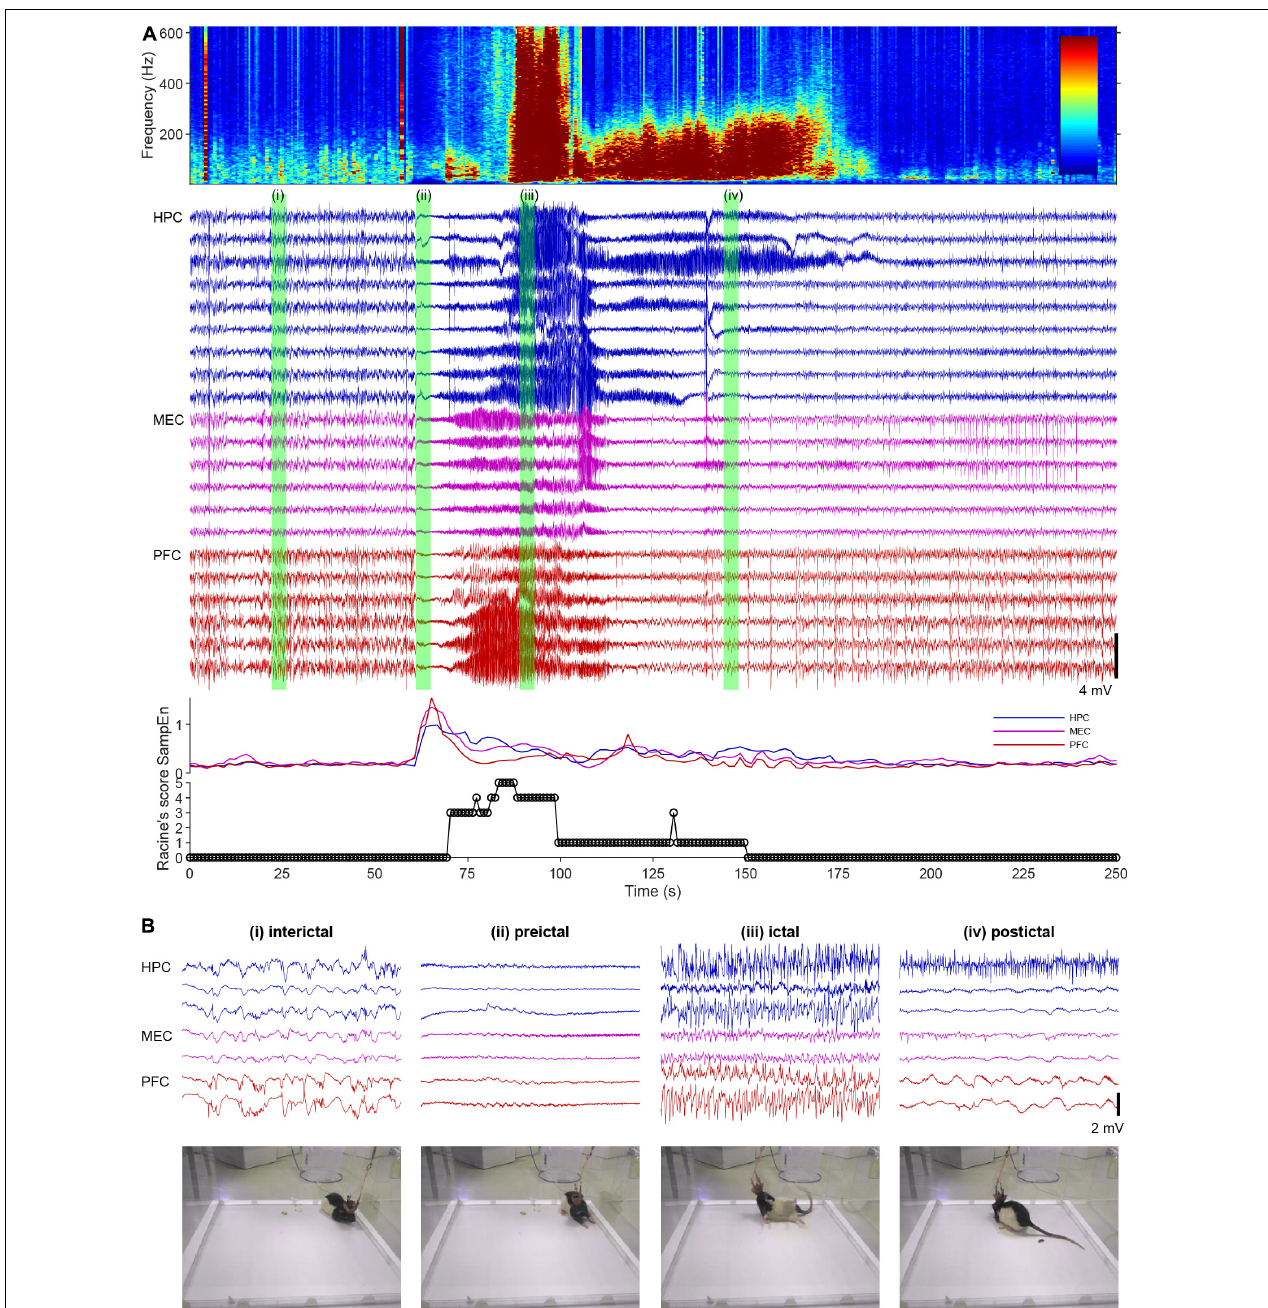
FIGURE 2 | A spontaneous seizure (ictal) episode with convulsion of a rat kainate-induced chronic model of temporal lobe epilepsy (TLE). (A) Local field potentials (LFPs) in the hippocampus (HPC), the medial entorhinal cortex (MEC), and the prefrontal cortex (PFC), time-frequency spectrogram of the third HPC channel, sample entropy, and behavioral manifestations over an ictal episode. Racine’s score: 1, mouth and facial movements; 2, head nodding; 3, forelimb clonus; 4, rearing; 5, rearing and falling (Racine, 1972). (B) Enlarged LFPs and snapshots of video monitoring green-labeled in (A) .